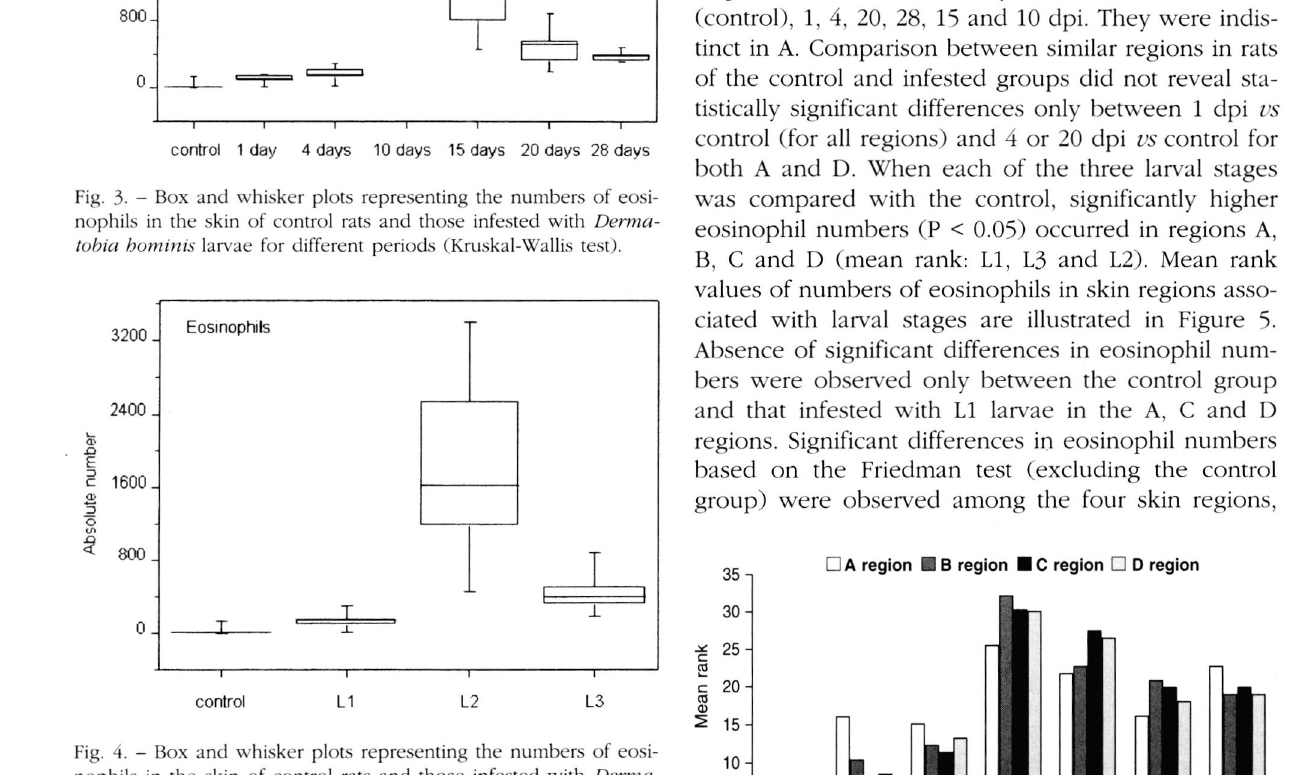
Fig. 4. - Box and whisker plots representing the numbers of eosi­ nophils in the skin of control rats and those infested with Derma­ tobia bominis based on larval development stage (Kruskal-Wallis test).